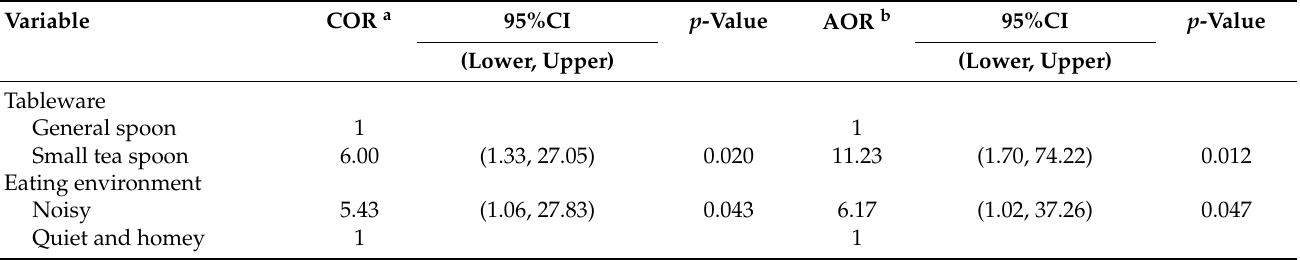
Table 4. Factors associated with aspiration pneumonia of the participants of nasogastric feeding with combined oral